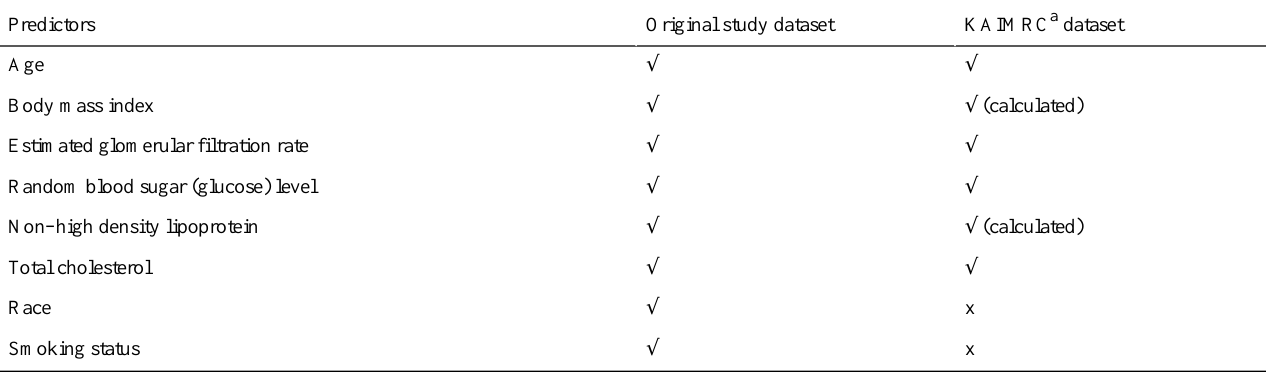
Table 1. Predictors available in the original study versus King Abdullah International Medical Research Center